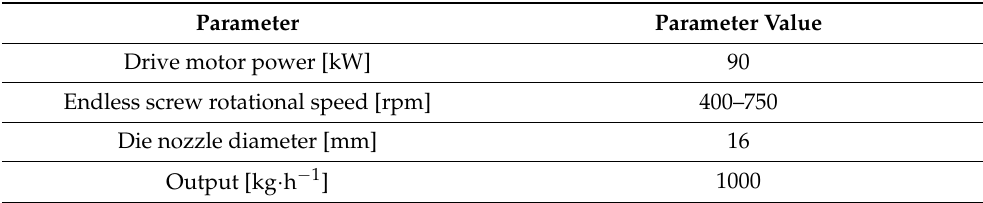
Table 3. The technical specifications of the E-1000 extruder.